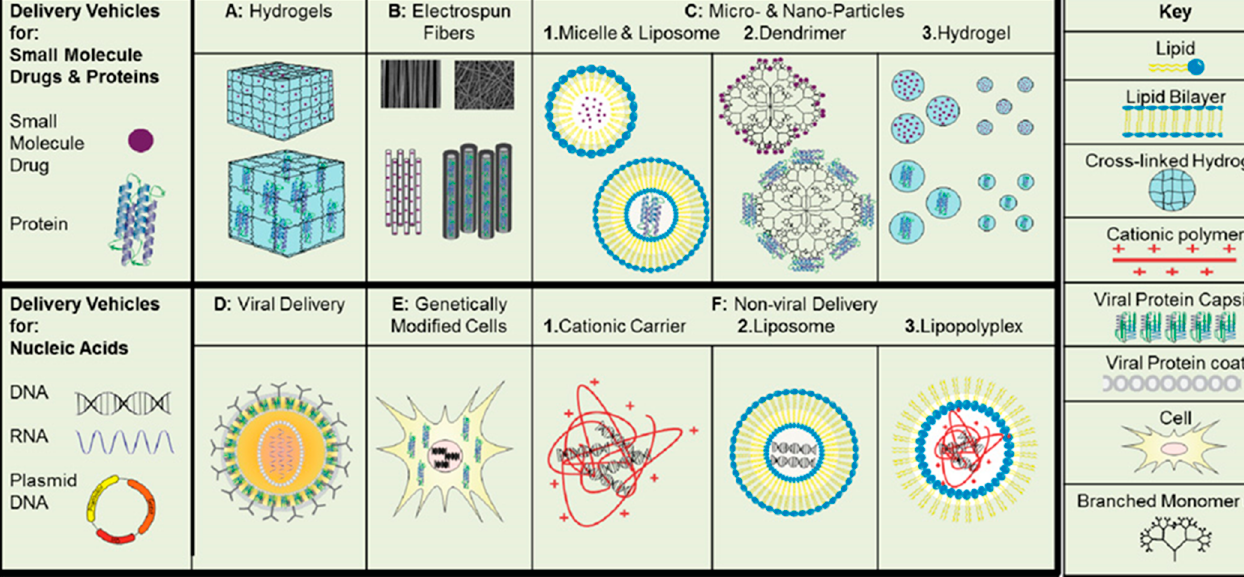
Figure 2. Types of the delivery vehicles used in regeneration therapies for soluble factors. Macroscopic carriers: hydrogels ( A ) and electrospun fibers ( B ). Microscopic carriers: liposomes and micelles ( C.1 ), dendrimers ( C.2 ), or particulate hydrogel systems ( C.3 ). Viral carriers ( D ) and genetically modified cells ( E ). Non-viral delivery vehicles: cationic polymers ( F.1 ), liposomes ( F.2 ) and lipopolyplexes ( F.3 ) [14].